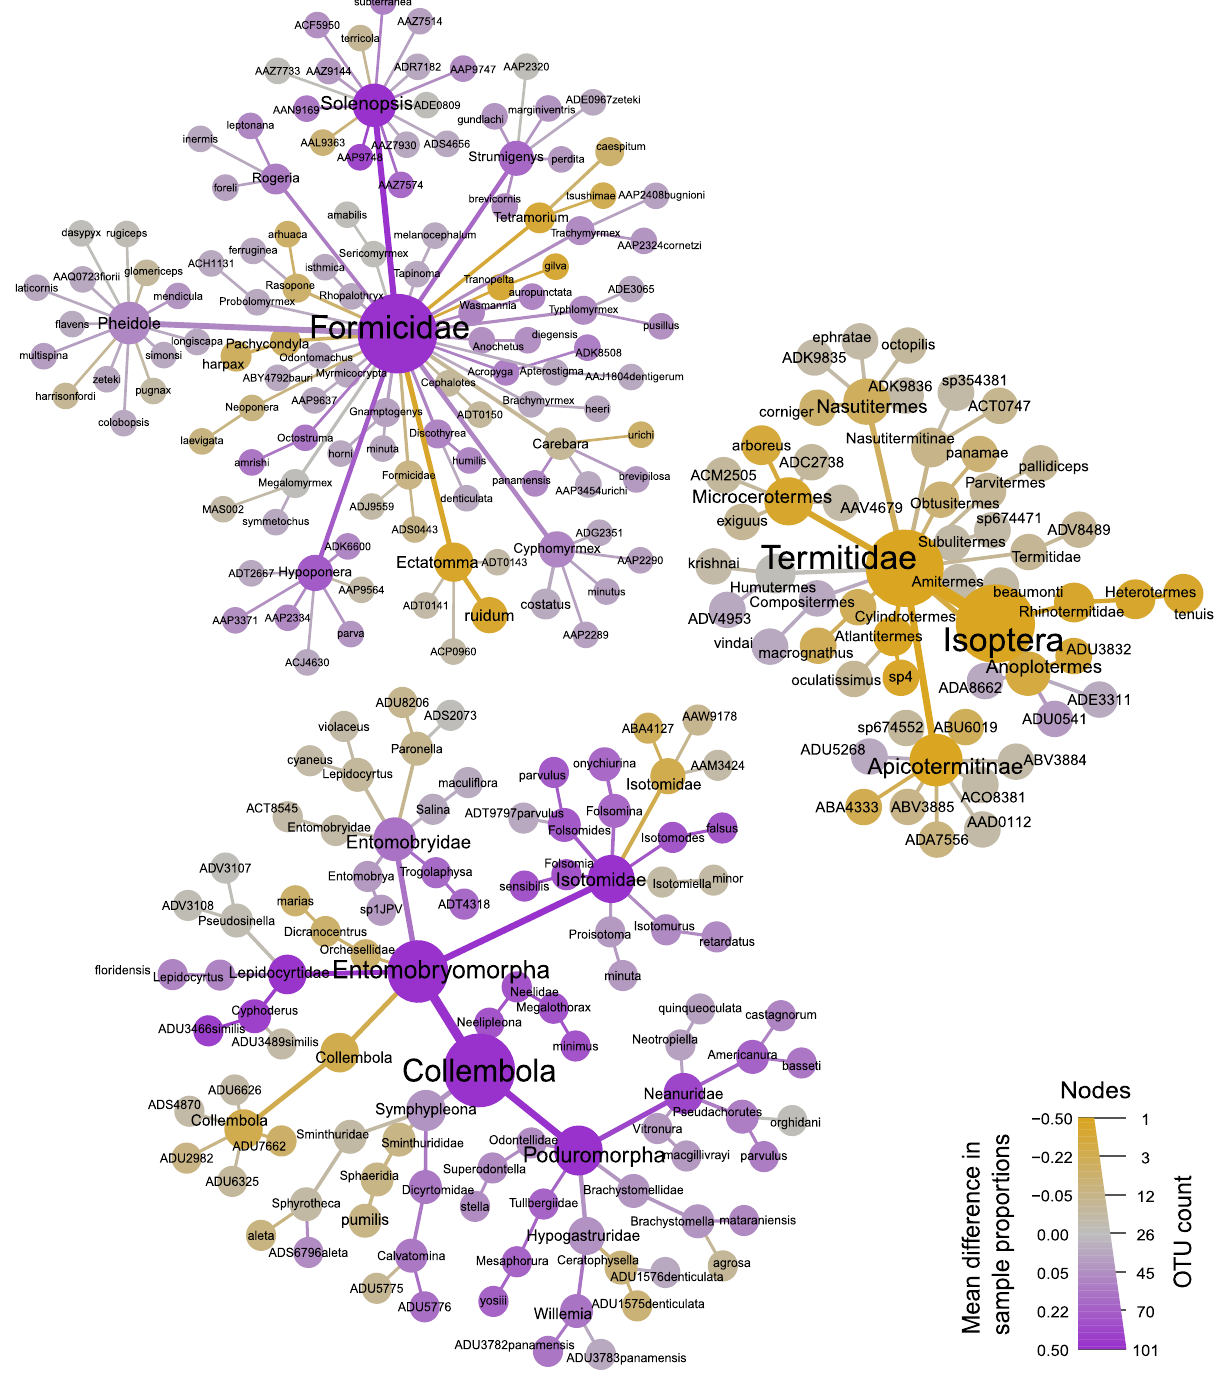
Figure 3. Taxonomic comparison between identification methods for the three focal groups. The size of each node represents the number of BINs for each hierarchical classification, while differences in color correspond to sampling methods (purple = traditional samples; brown-orange = metabarcoding samples; gray = occurring in both). The heat map was created with Metacoder 0.3.5 https:// cran.r- proje ct. org/ web/ packa ges/ metac oder/ index. html 62